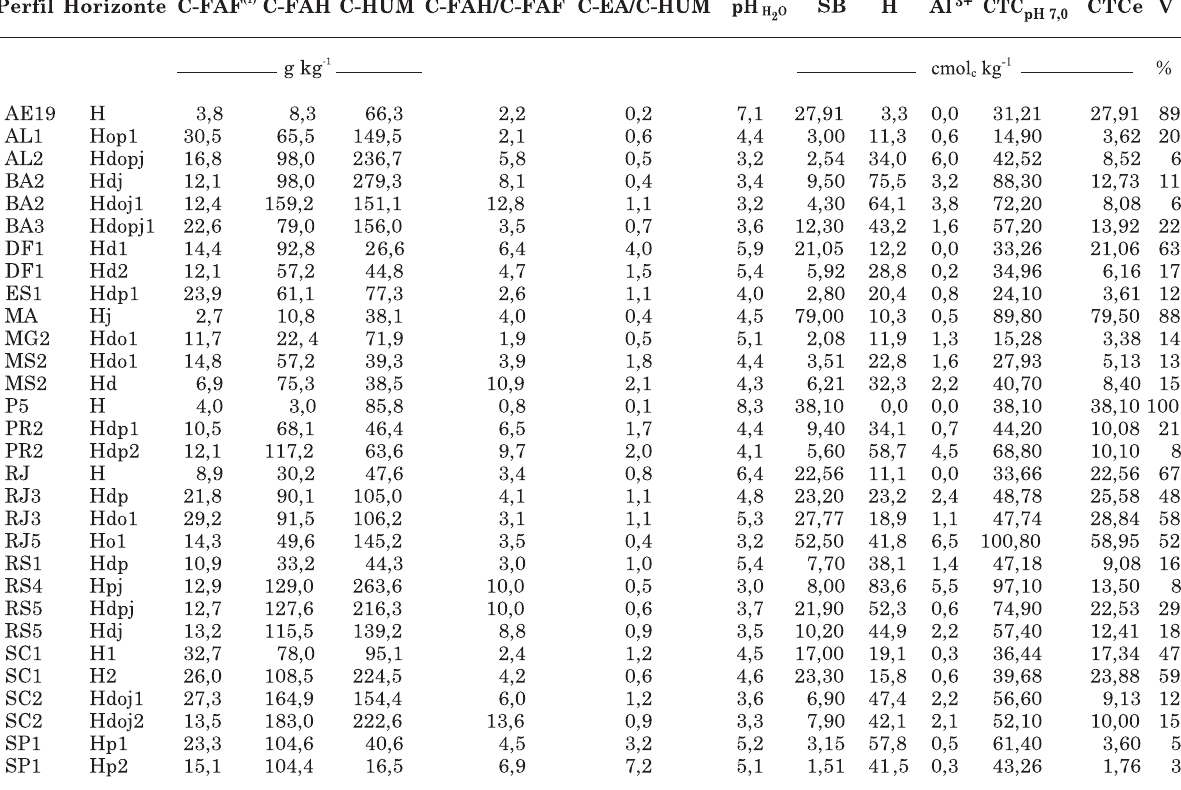
Horizontes A chernozêmico Diferindo dos horizontes anteriores, esses minerais apresentaram menor variação dos teores das frações húmicas e dos atributos químicos e físicos (Quadro 7). Observa-se o predomínio da humina, com altos